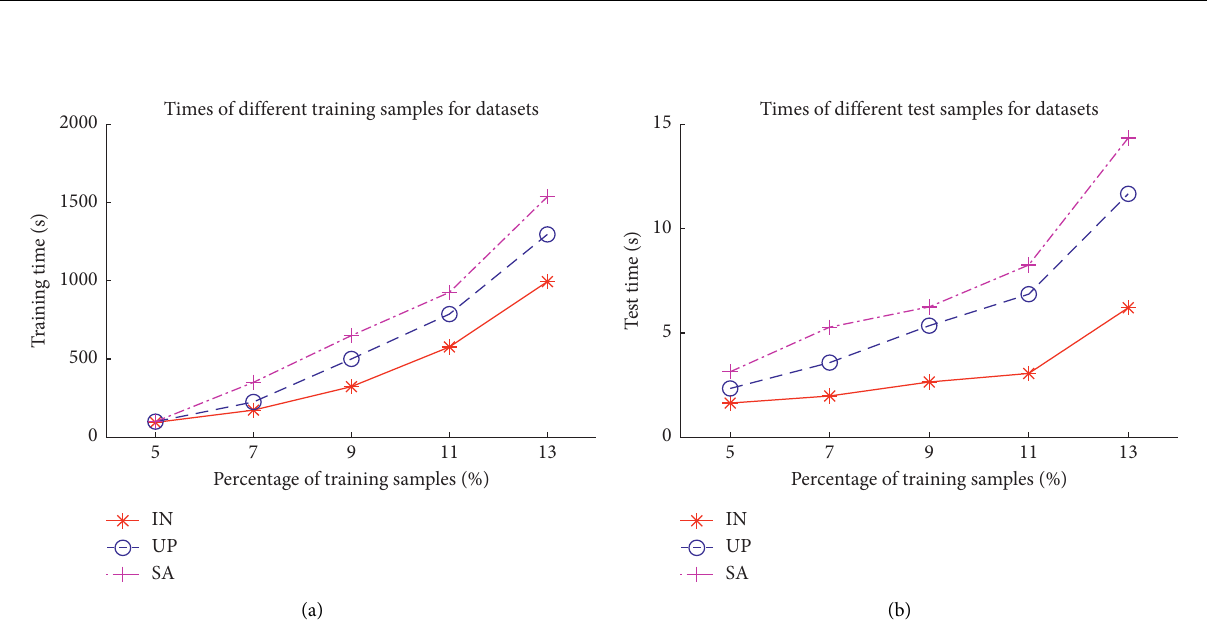
Figure 10: (a) Training time and (b) test time of different spatial window sizes for three